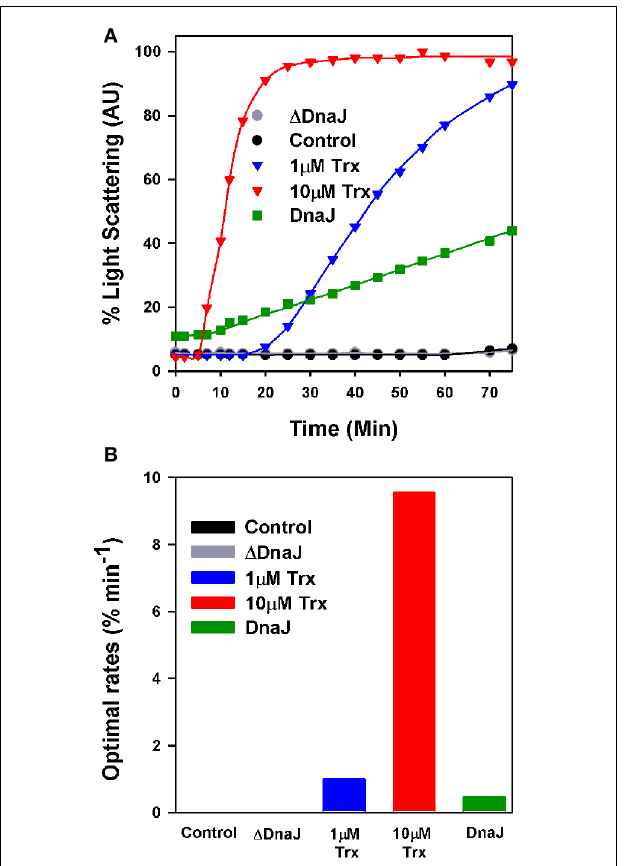
FIGURE 2 | The cysteine-rich domain of DnaJ has a thiol-reductase activity. (A) Time dependent insulin turbidity assay: Native insulin (130 μ M) in presence of 0.45mM DTT was supplemented either with thioredoxin (1 and 10 μ M), DnaJ (30 μ M) or (cid:2) DnaJ (30 μ M) as indicated. The maximal insulin light scattering signal at 40min following addition of 10mM DTT was set as 100%. (B) Optimal rates of insulin turbidity formation calculated in the linear region, from the inflection point, of the sigmoidal curves of (A)